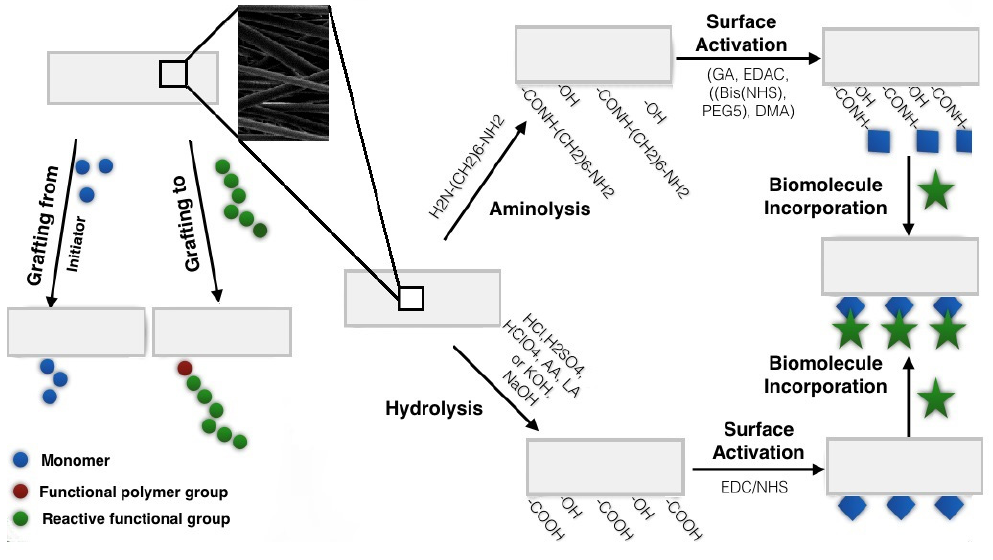
Figure 1. Chemical functionalization of electrospun nanofibers.